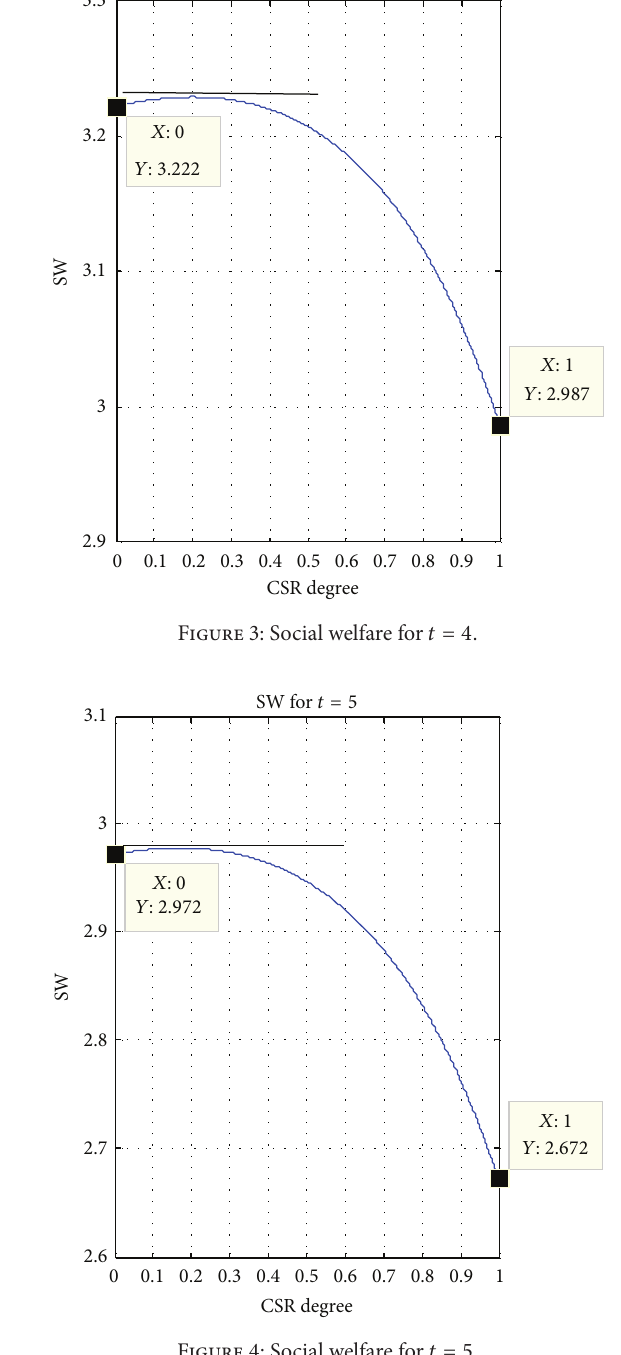
Figure 4: Social welfare for 𝑡 = 5